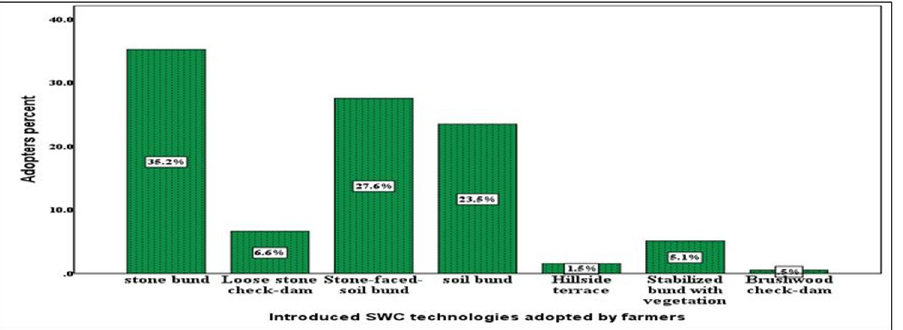
Fig 8. Soil and water conservation practices in Lege-lafto